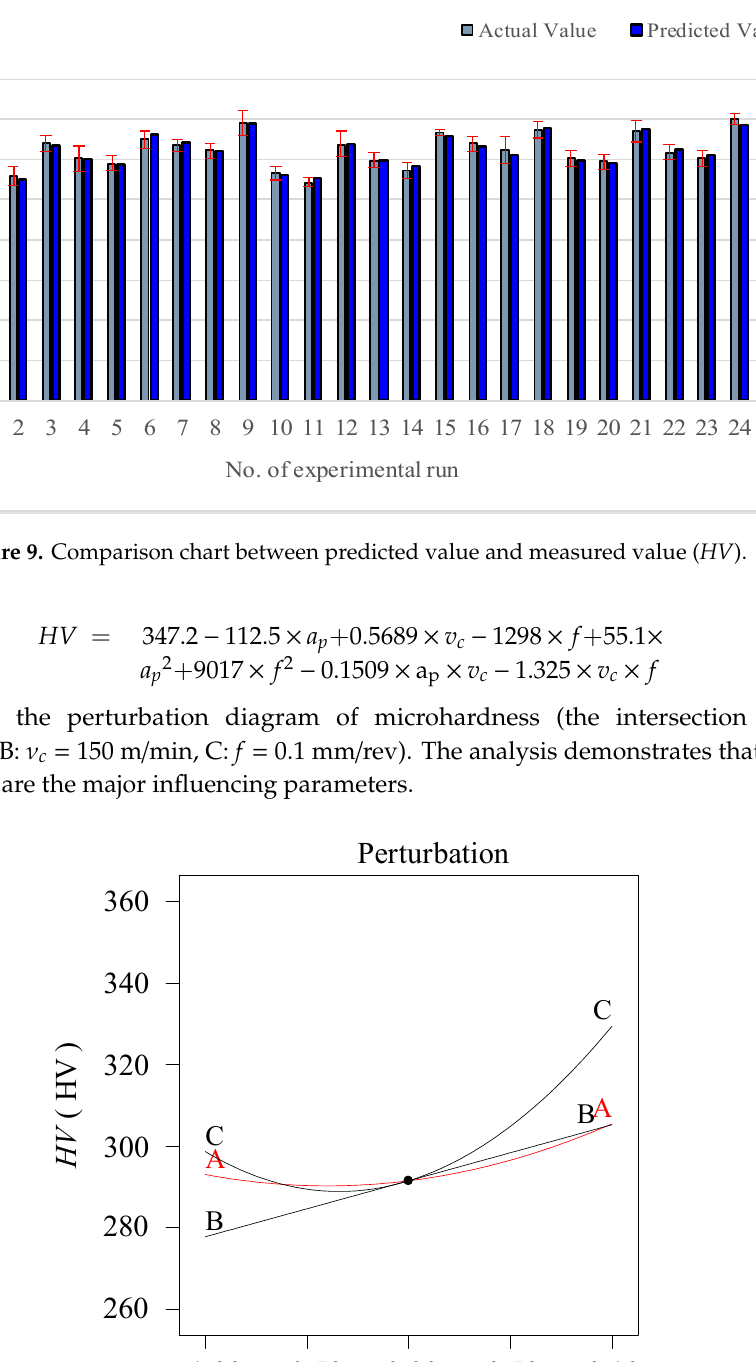
Figure 10. Perturbation diagram ( HV ).